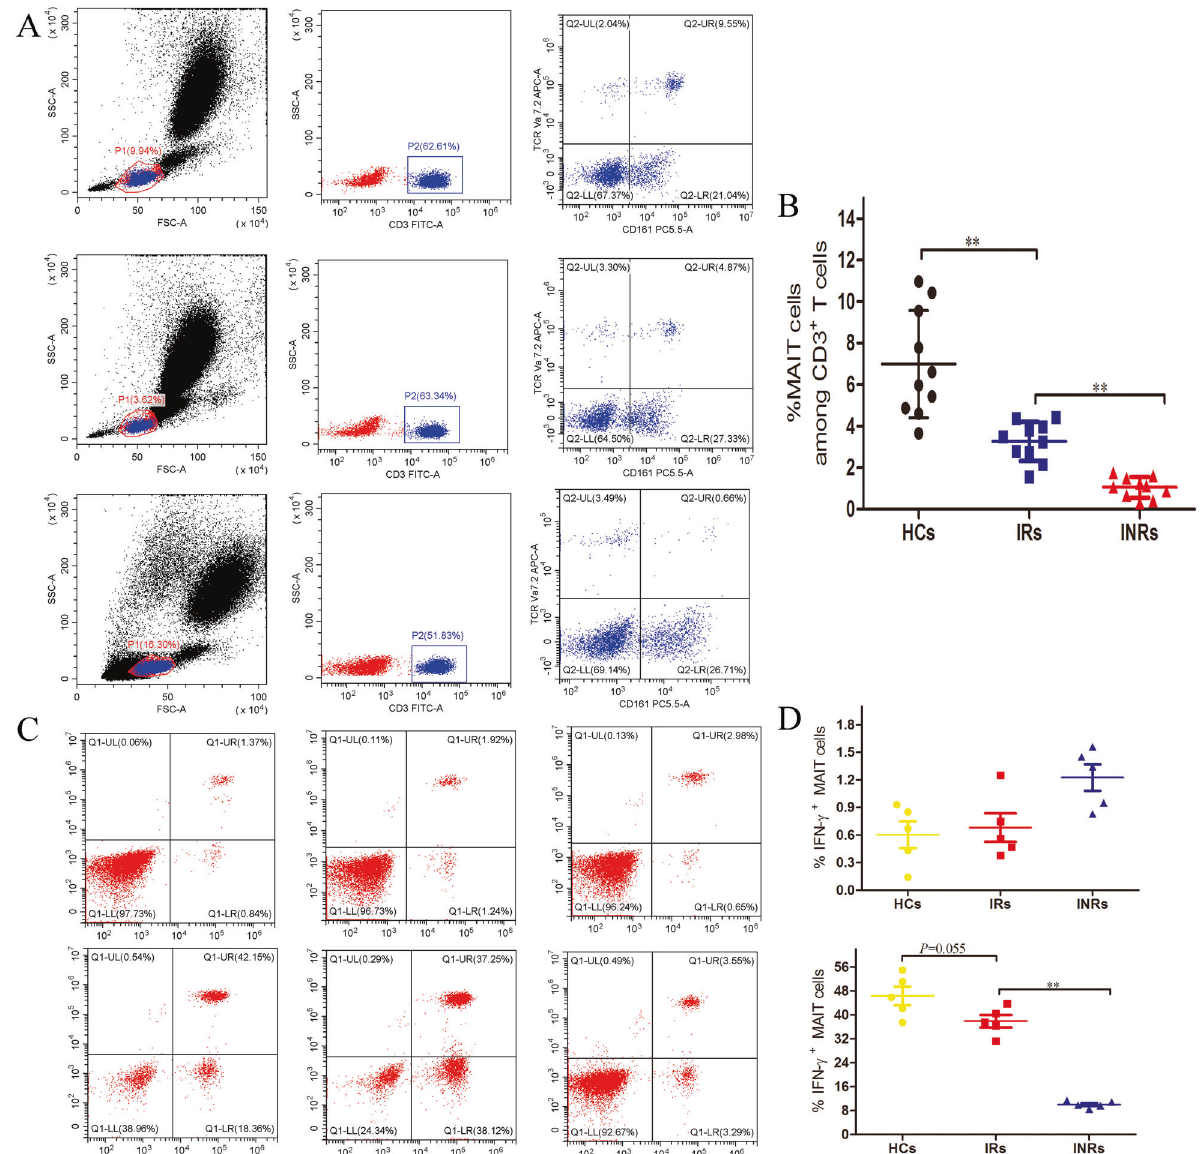
Fig. 2 MAIT derived from INR is dysfunctional. A , B Proportions of MAIT cells detected in PBMCs from healthy controls (HC), immune non- responder (INR) HIV-1-infected subjects and immune responder (IR) HIV-1-infected subjects. Representative FC ( fl ow cytometry) plots ( A ) and statistical analysis ( B ) are shown. C , D Detection of interferon-gamma produced by MAIT after PBMC isolated from HCs, INRs, and IRs was stimulated by paraformaldehyde (PFA)- fi xed E. coli